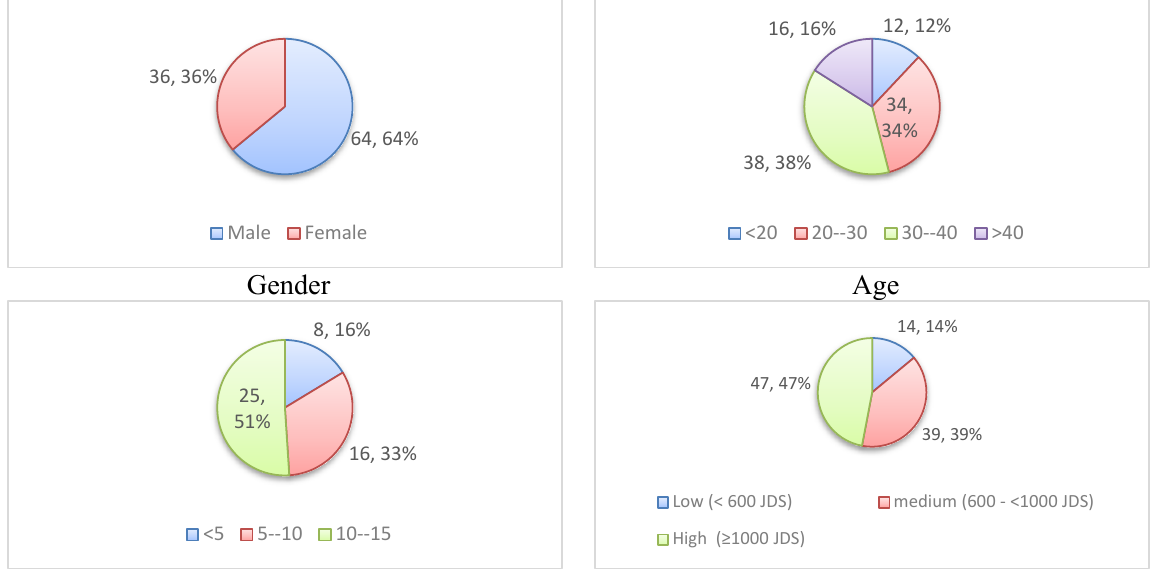
Fig. 2. Personal characteristics of the